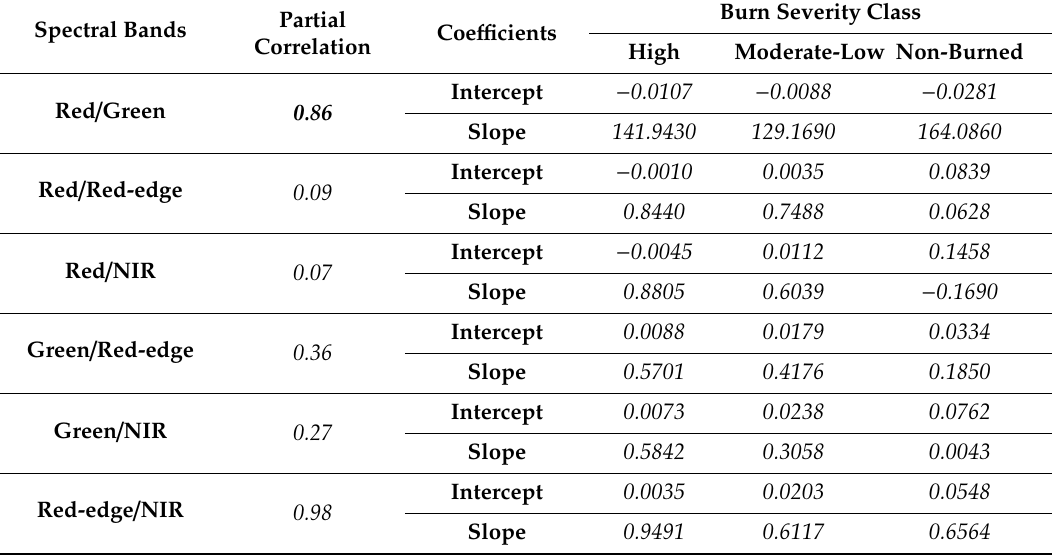
Table 1. Partial correlation coe ffi cient, intercept and slope of the linear regression among the four Unmanned Aerial Vehicle (UAV) spectral bands for each burn severity class (high, moderate-low and non-burned).